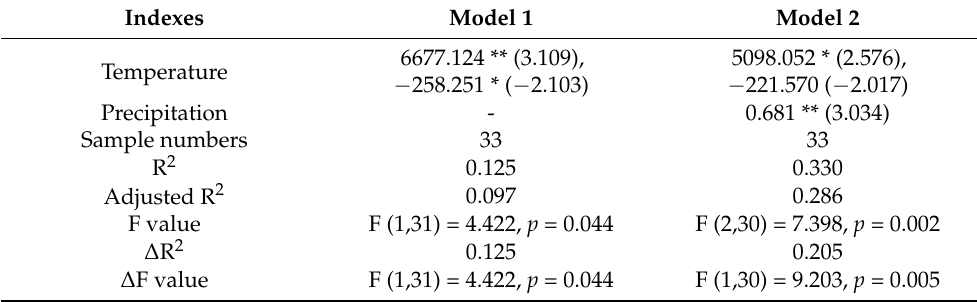
Table 6. Result of the hierarchical regression analysis for meteorological Table 7. Correlation coefficients between different runoffs and precipitation.